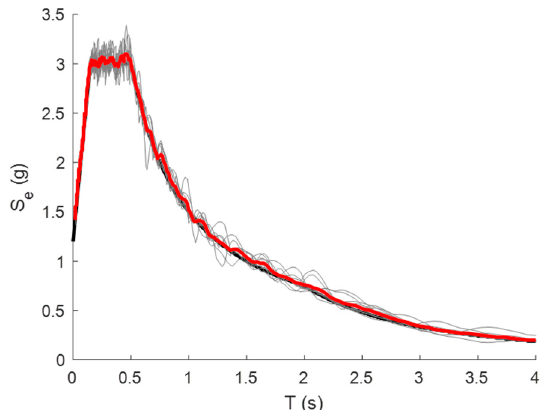
Figure 13. Acceleration response spectra (in grey) of the artificial ground motions used in the non-linear dynamic analyses. The target spectrum is shown in black (scaled here to a g = 1.0 g), while the average of the spectra is indicated in red.